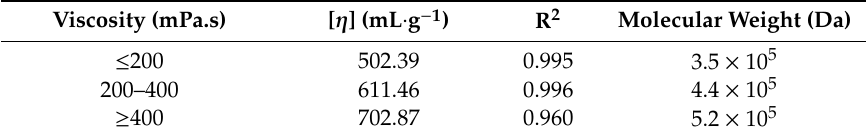
Figure 2. Intrinsic viscosity of CTS in 0.2 M HAc/0.1 M NaAc at 30 °C. Table 2. Molecular weight of chitosan with di ff erent Table 2. Molecular weight of chitosan with different viscosities.